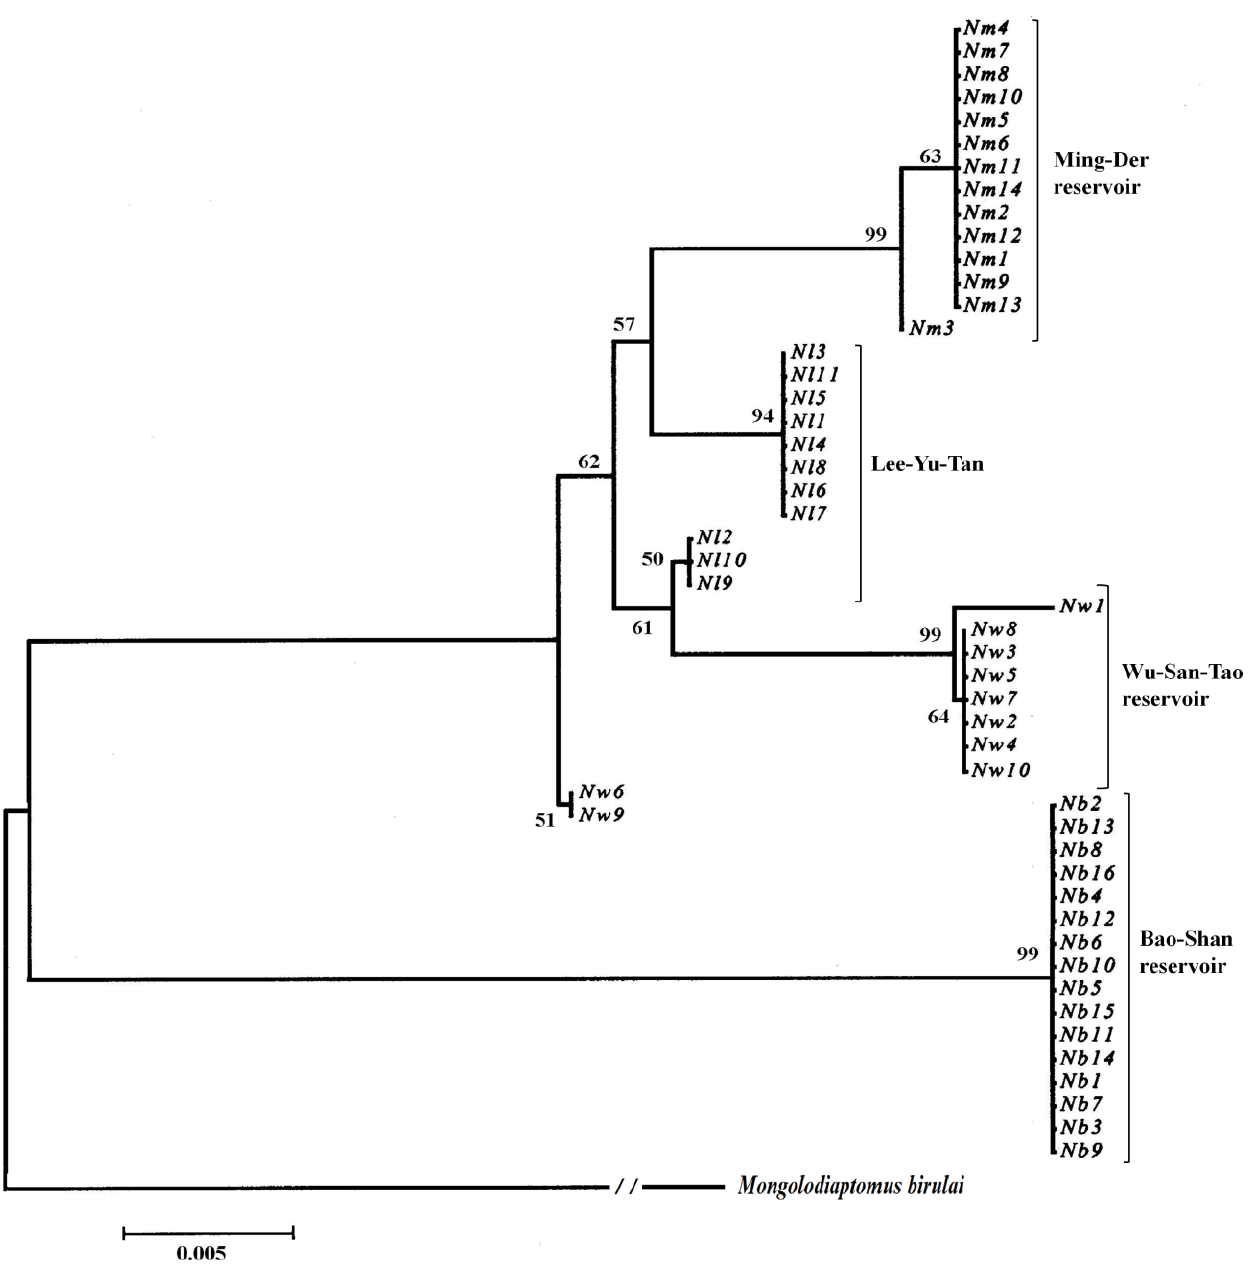
Figure 2. The geophylogenetic tree of Neodiaptomus schmackeri constructed by the neighbor-joining method based on the Kimura 2-parameter process with 1,000